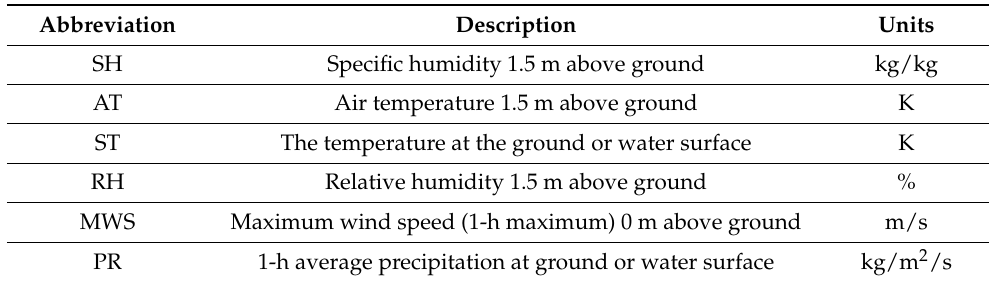
Figure 2. Summary of the global, regional, and local forecasting models by KMA. Table 3. Candidate explanatory variables from LDAPS for the spatial gap-filling of GK2A daily SST.